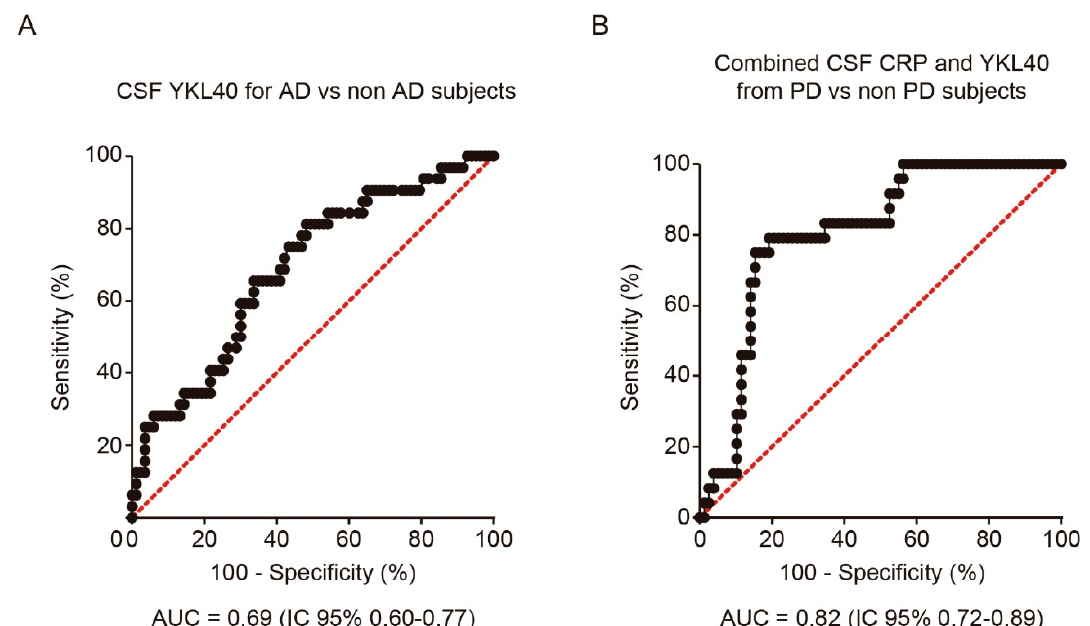
Figure 2. Receiver operating characteristic (ROC) analysis of YKL-40 and CRP levels in CSF. ( A ) ROC curve and its corresponding area under the curve (AUC) differentiating YKL-40 levels in CSF from AD patients and non-AD subjects including control subjects. ( B ) AUC differentiating the combination of YKL-40 and CRP levels in CSF from PD and non-PD patients. AUC, area under the curve; AD, Alzheimer’s disease dementia; PD, Parkinson’s disease.